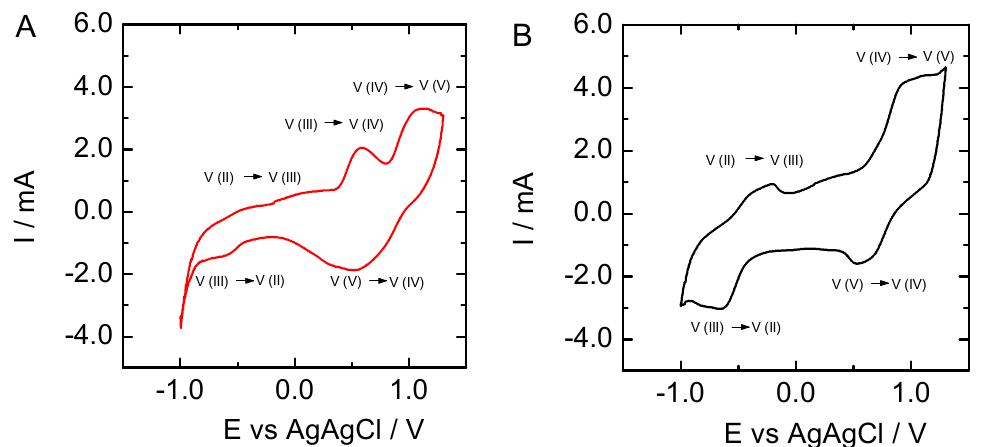
Figure 7. Cyclic voltammograms recorded at 5 mV · s − 1 in 3 M H 2 SO 4 and 0.15 M V(III)/V(IV) solution for CNFs derived from ( A ) KL; ( B ) KL loaded with Ketjen black.